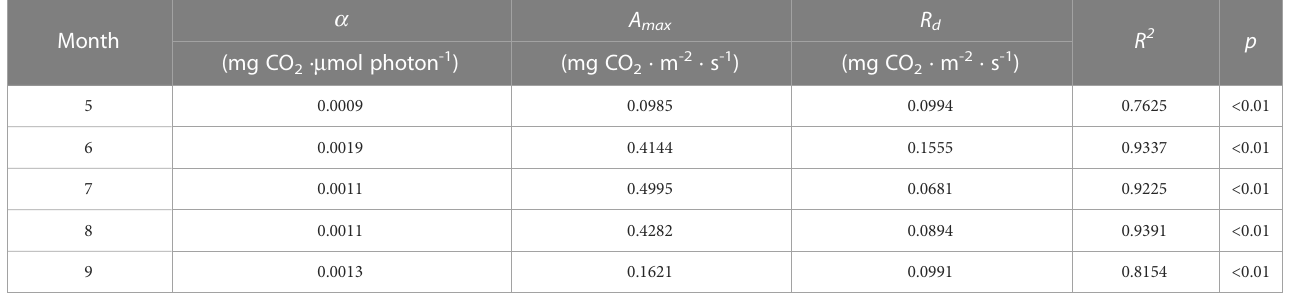
TABLE 6 Parameters of NEE (net ecosystem CO 2 exchange) light response curves during the growing seasons in the boreal forest ecosystem.